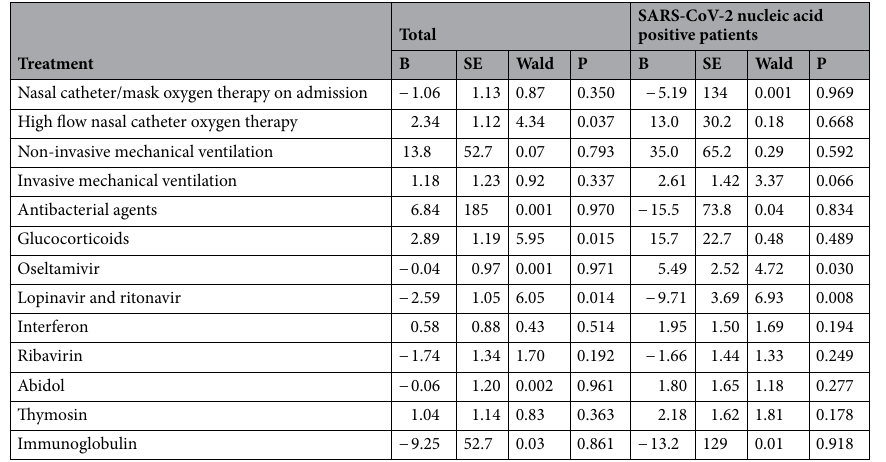
Table 3. Cox regression analysis for risk of death following different treatments and final prognosis of COVID-19